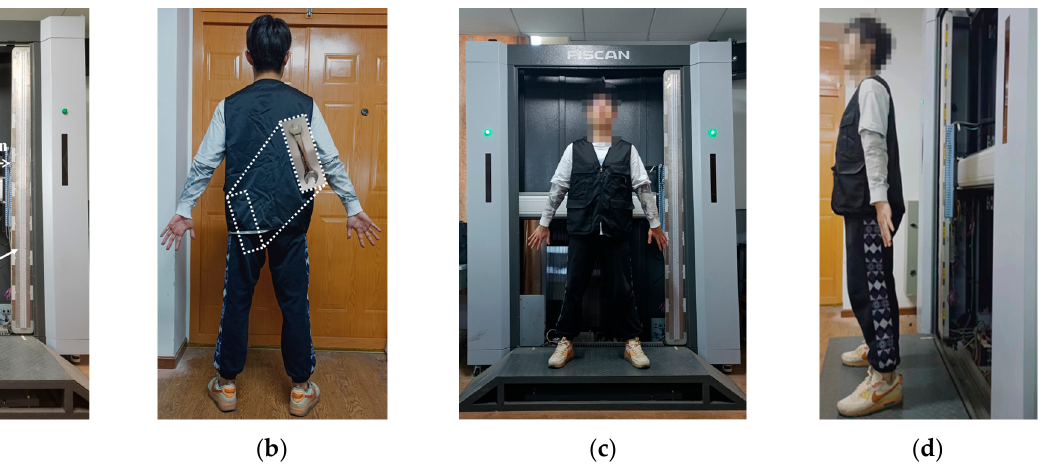
Figure 4. ( a ) MMW radar imaging prototype, ( b ) subject with a wrench, ( c ) the front view and ( d ) the side view of the measurement scene during MMW echo collection.